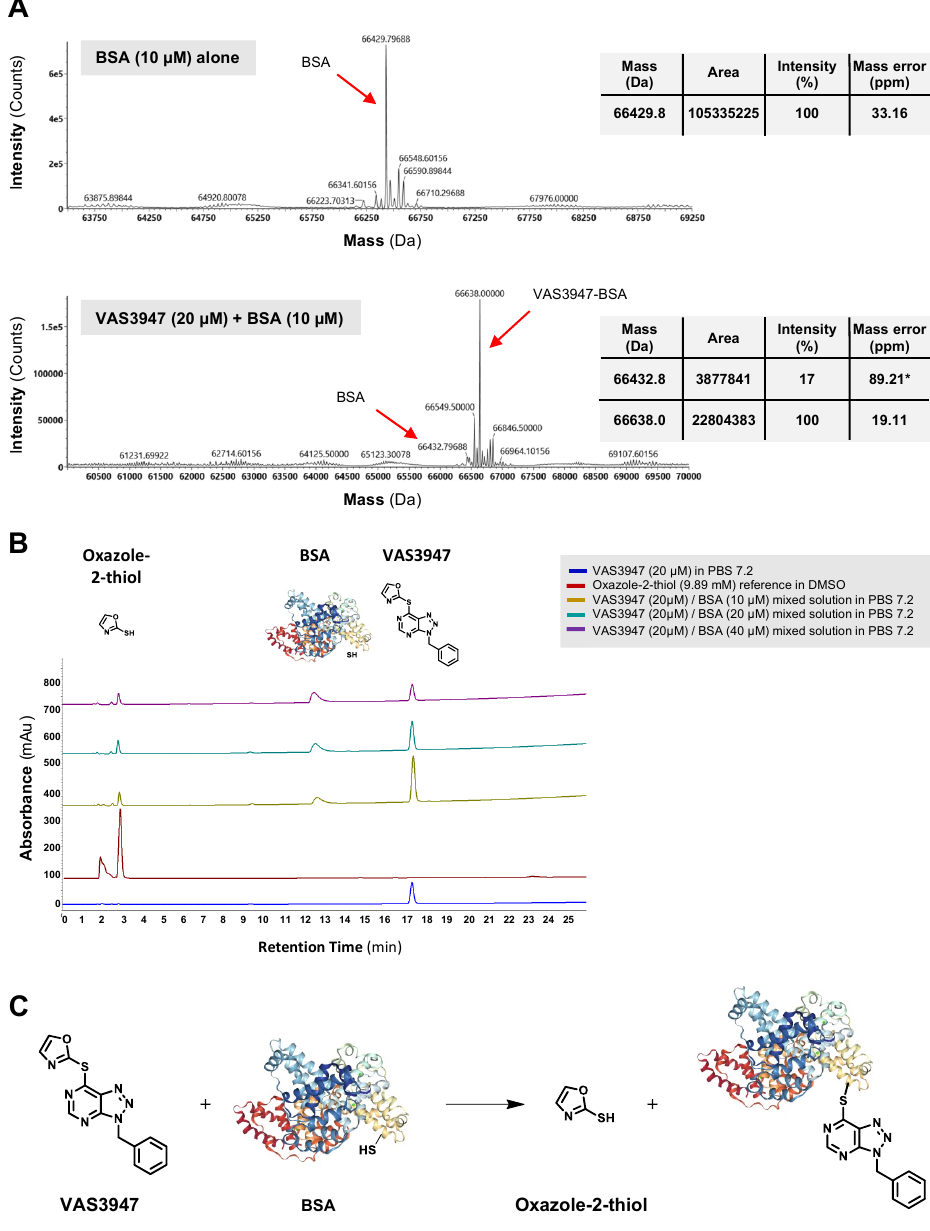
Figure 4. LC-ESI MS and HPLC analysis of the BSA modification by VAS3947. ( A ) Extracted ion current chromatograms and corresponding mass spectra are shown for VAS3947 and a VAS3947/BSA mixture (20 min incubation). * Low intensity observed for BSA makes it difficult for the MaxEnt1 algorithm to catch a mass with high precision for this protein. ( B ) HPLC analysis for the same solution of VAS3947, oxazole-2-thiol, and the VAS3947/BSA mixture. ( C ) MS and HPLC analyses indicate that the thiol function of BSA is alkylated by the benzyltriazolopyrimidine moiety of VAS3947, with the oxazole-2-thiol moiety of VAS3947 serving as leaving group.